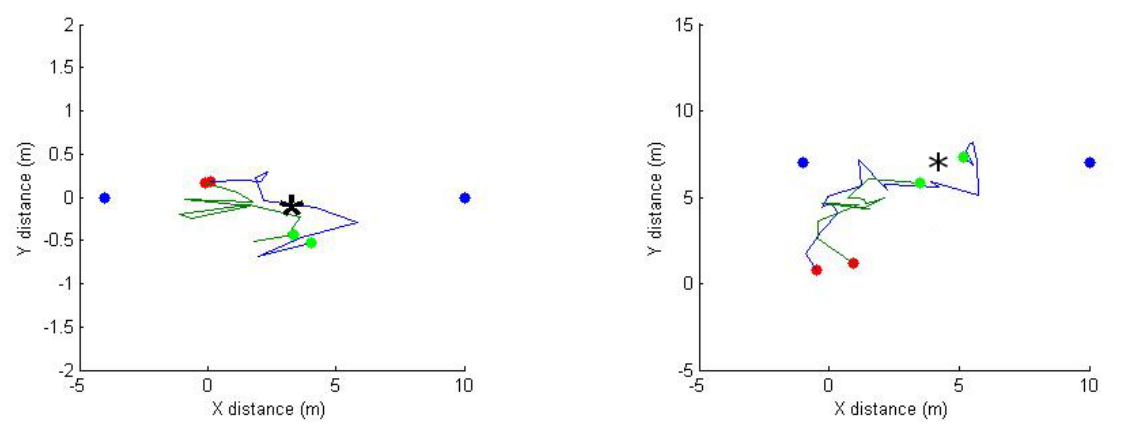
Figure 16. Path taken by the relay node in two different trials when the initial positions are almost the same. Server and client node are shown as blue dots. Red and green dots indicate initial and final relay node position, respectively. The theoretical optimum position is marked as *.